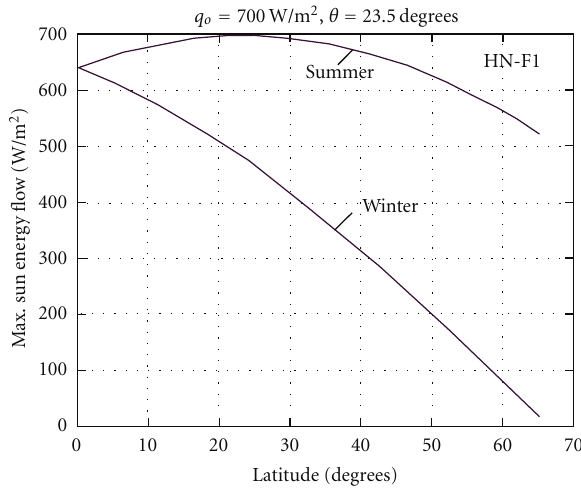
Figure 11: Maximum solar radiation flow at Earth’s surface as fun- ction of the Earth latitude and season.